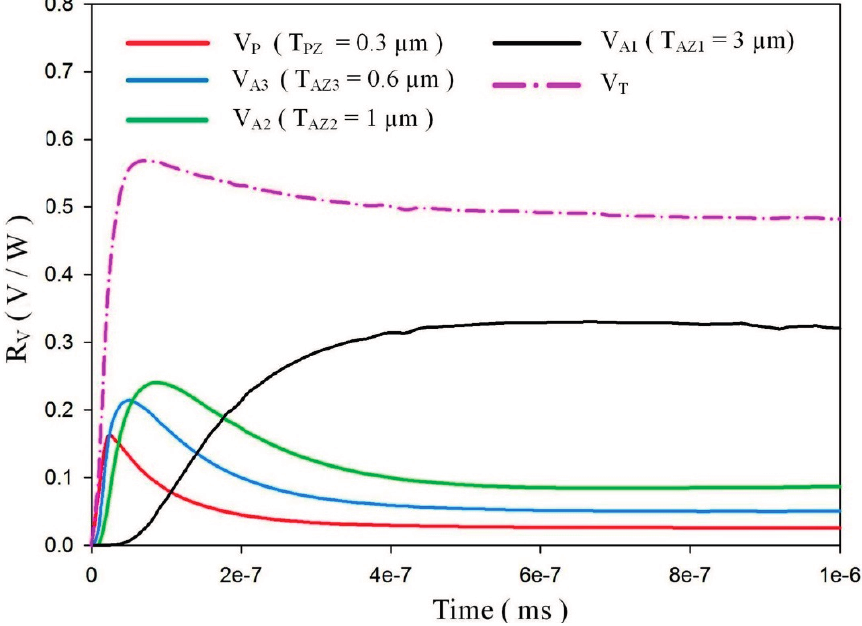
Figure 9. Relationship between the calculated voltage responsivities and time in a meliorated multi-frequency band pyroelectric sensor under sputtered ZnO film with a constant thickness of 0.3 μ m and aerosol ZnO films with three thicknesses from 0.6 to 3 μ m. Transient temperature fields with various chopping frequencies were simulated for further calculation of voltage responsivities when the meliorated multi-frequency band pyroelectric sensors were exposed to irradiation power with various chopping periods. A square waveform was produced using a programmable function generator to modulate the irradiation power with chopping frequencies of about 14 KHz, 33 KHz and 100 KHz. Figure 10 shows the voltage responsivities of a meliorated multi-frequency band pyroelectric sensor with T PZ = 0.3 μ m, T AZ1 = 3 μ m, T AZ2 = 1 μ m and T AZ3 = 0.6 μ